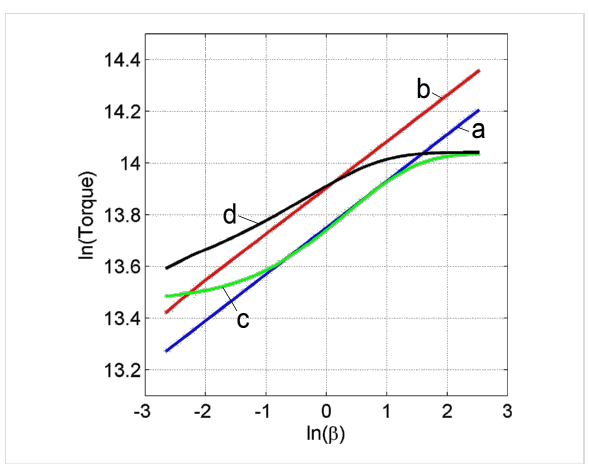
Figure 5: Dependence of torque on β in log–log coordinates. Each curve is indexed with the index of the respective conditions given in Table